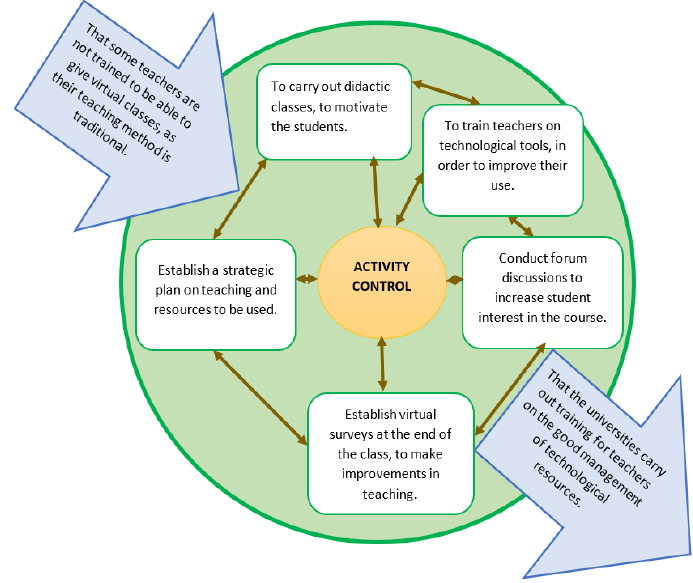
Fig. 12. Conceptual model applied to